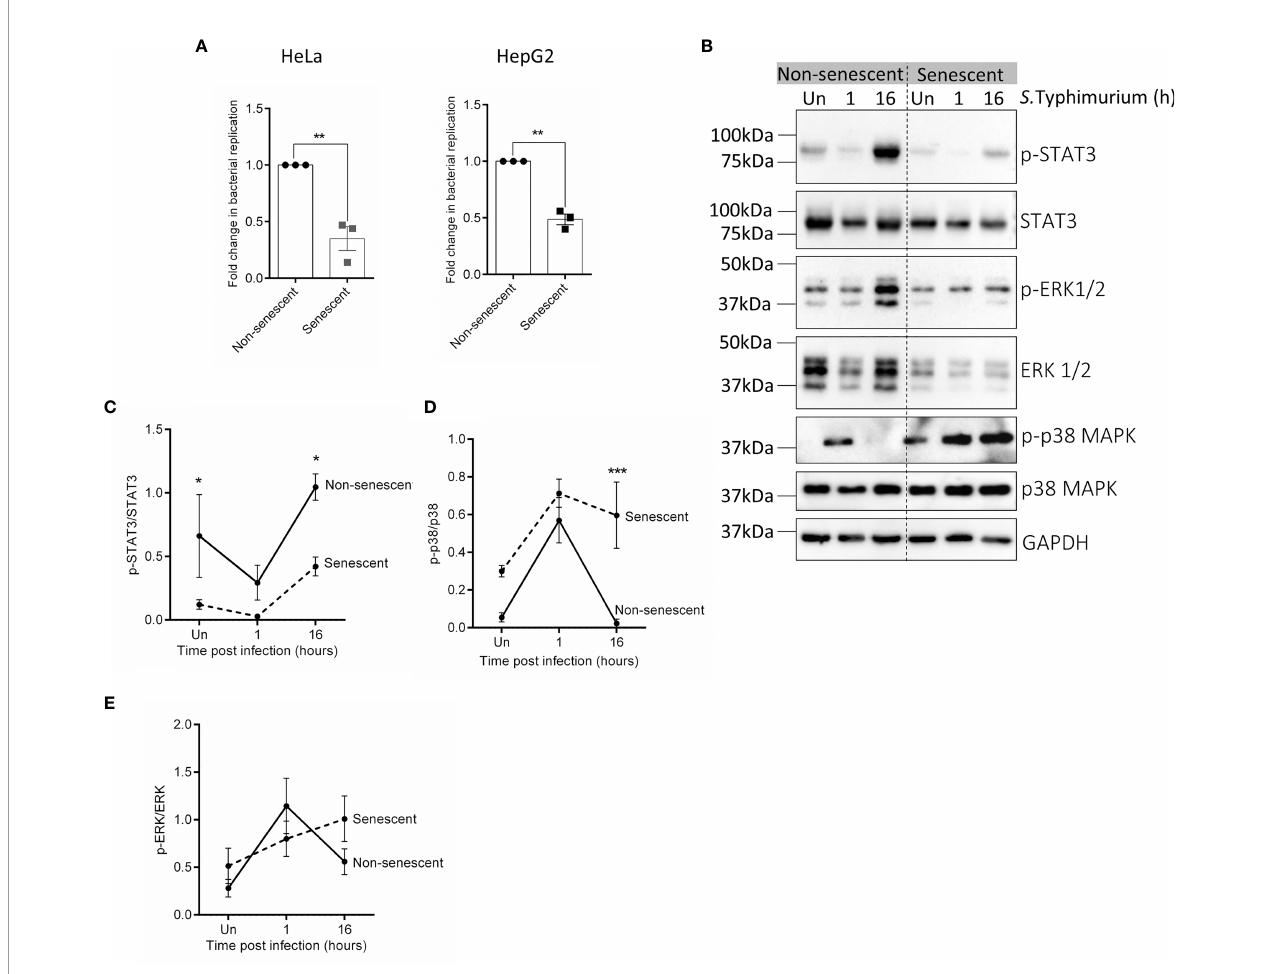
FIGURE 1 | Infection and activation of various kinase varies between non-senescent and senescent HeLa cells. (A) Equal numbers of non-senescent and senescent HeLa or HepG2 cells were seeded and co-incubated with S.Typhimurium (MOI=10) for 1h (invasion). Extracellular bacteria were then killed with 100µg/mL Gentamicin containing complete medium for 30 minutes and host cells were then lysed to enumerate the number of bacteria that had invaded. Parallel wells were maintained in 10 µg/mL Gentamicin containing medium for 16h after which host cells were lysed to enumerate viable bacteria in the cells at 16h post-invasion. Bacterial replication was determined by dividing CFU at 16h by CFU at 1h of infection (invasion). Fold change in bacterial replication was then plotted relative to nonsenescent cells. Statistical signi fi cance of differences was analysed by Independent t-test, **P ≤ 0.01. (B) Western blot for phosphorylated and total levels of STAT3, ERK1/2 and p38 MAPK in uninfected and infected non-senescent and senescent HeLa cells. GAPDH is used as a loading control. (C – E) Quanti fi cation of phosphorylated levels of STAT3 (C) , p38 MAPK (D) and ERK1/2 (E) relative to their total levels, respectively in non-senescent and senescent HeLa cells. The data represents mean ± SEM from atleast three independent experiments. Statistical signi fi cance of differences was analysed by Two-way ANOVA followed by posthoc Fisher ’ s LSD test, *P ≤ 0.05, ***P ≤